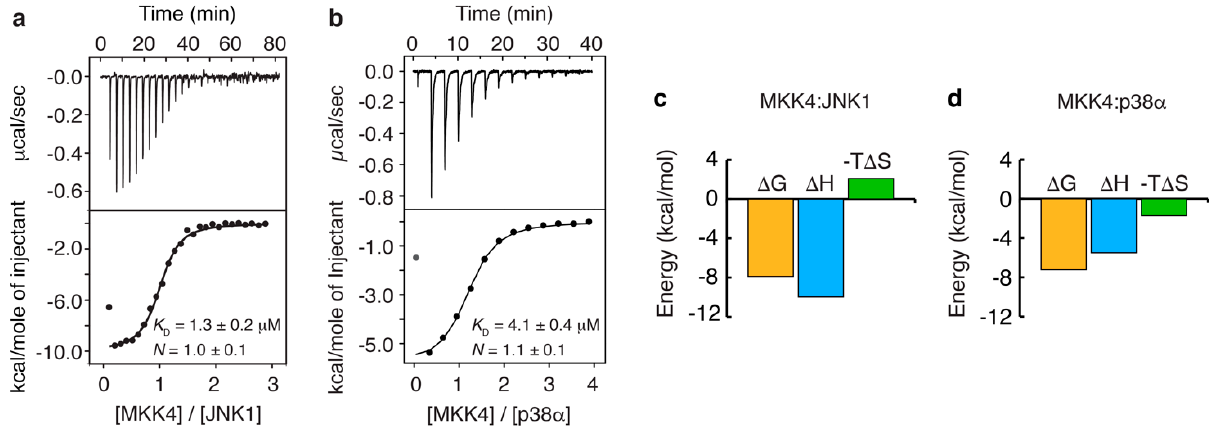
Figure 4. ITC data of the interaction of MKK4 with JNK1 ( a ) and p38 α ( b ). Representative data are shown with raw injection heats (upper) and the corresponding specific binding isotherms (lower). The data were analyzed according to a model of n identical and independent binding sites. The corresponding dissociation constants ( K D ) and stoichiometries ( N ) are reported with error bars corresponding to the fitting error in Origin. The binding free energies were dissected into enthalpic and entropic contributions for both the MKK4:JNK1 ( c ) and MKK4:p38 α ( d ) complexes. The ITC data of the p38 α complex were previously acquired [35].